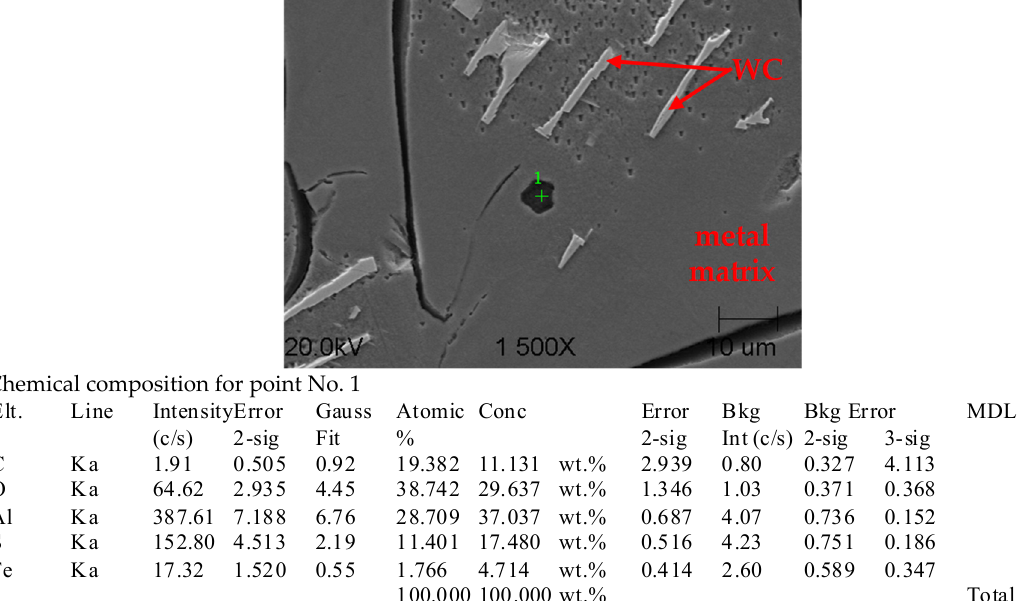
Chemical composition for point No. 1